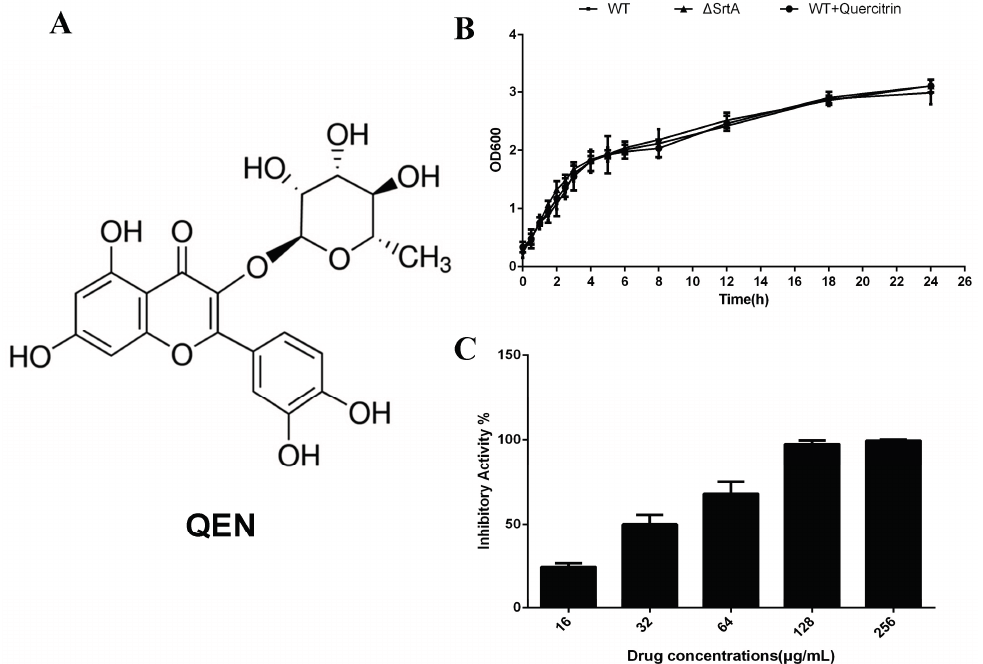
Figure 1. QEN blocks the thioesterification process of SrtA catalysis, but does not inhibit bacterial physiology. ( A ) The chemical structure of QEN. ( B ) The growth curve of S. aureus treated with or without QEN. S. aureus were cultured in BHI without QEN or with 256 μ g/mL QEN, and the absorbency readings of the samples were taken at OD 600 at the indicated time point. ( C ) QEN blocks the catalytic activity of SrtA. The fluorescent peptide was incubated with purified SrtA treated with the indicated concentrations of QEN at 37 °C for 30 min, and the fluorescence was measured 1 h after adding the substrate-modified